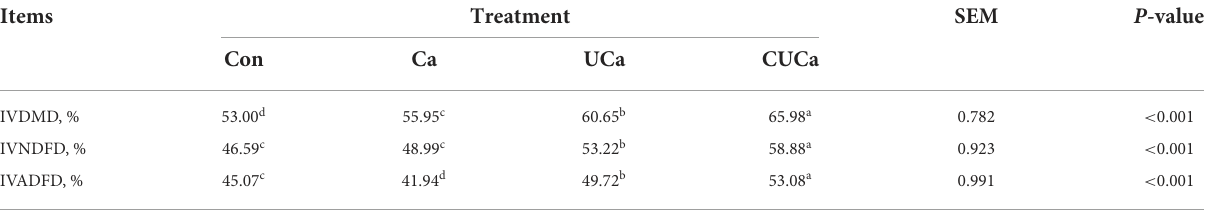
TABLE 2 Effect of CSL plus urea-alkali pretreatment on digestibility of DM, NDF, and ADF of rice straw in vitro after 15 days of storage.